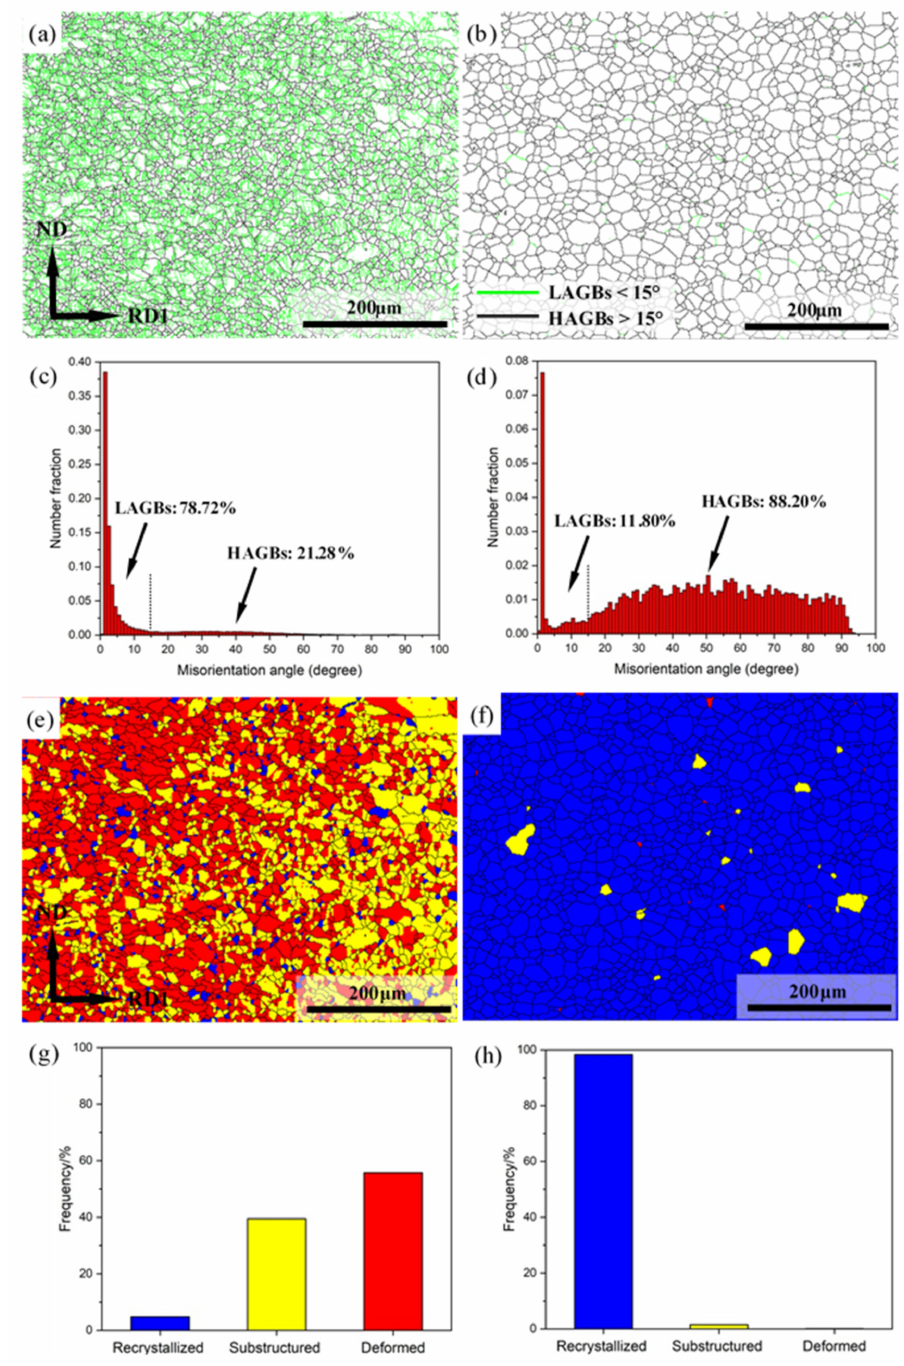
Figure 14. Grain boundary maps of ( a ) as-rolled and ( b ) as-annealed; misorientation angle distribu- tions of ( c ) as-rolled and ( d ) as-annealed; structure component distribution maps of ( e ) as-rolled and ( f ) as-annealed; and structure fraction distributions of ( g ) as-rolled and ( h ) as-annealed Mg-3Y